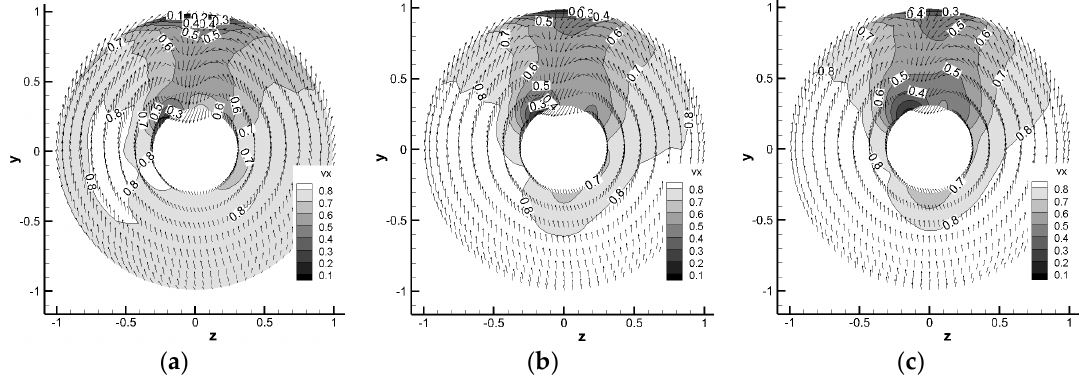
Figure 9. The predicted effective wake field at the advance ratios of ( a ) Js = 0.7; ( b ) Js = 0.9; and ( c ) Js = 1.1. Only the effective wake distribution on the mid-chord disk is shown. The actual effective wake field may vary in the axial direction.